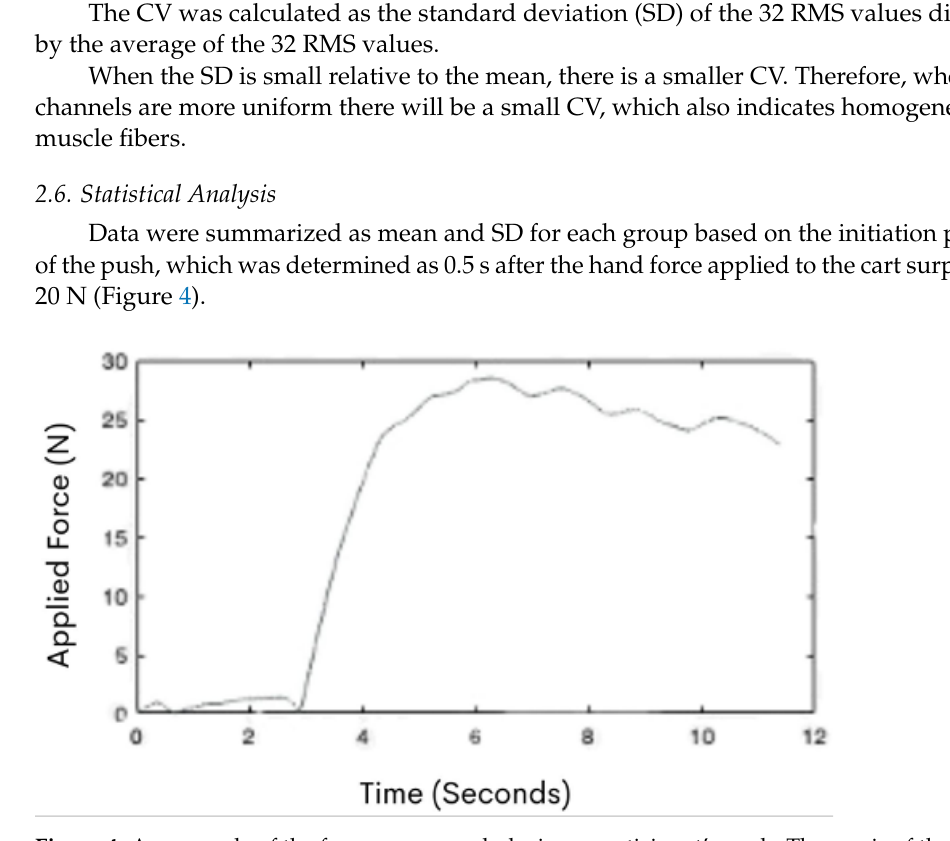
Figure 4. An example of the force curve graph during a participant’s push. The x -axis of the graph represents time (s), while the y -axis represents force (N).